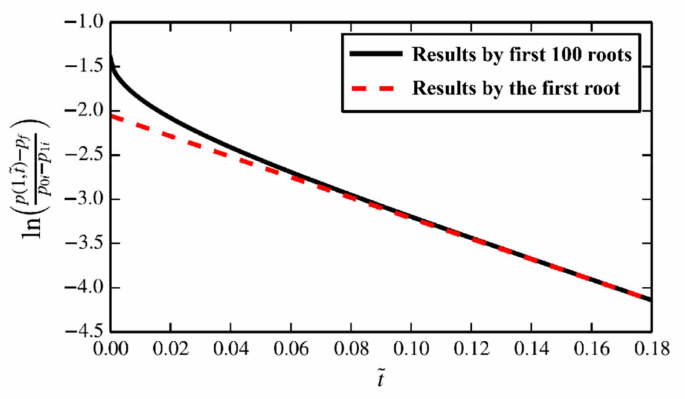
Figure 2. The truncation result of the analytic solution. The solid line represents the result of the truncation for the first 100 characteristic roots of Equation (11) and the dotted line represents the result of the truncation for the first characteristic root. When the dimensionless time is greater than 0.1, there is little di ff erence between the two